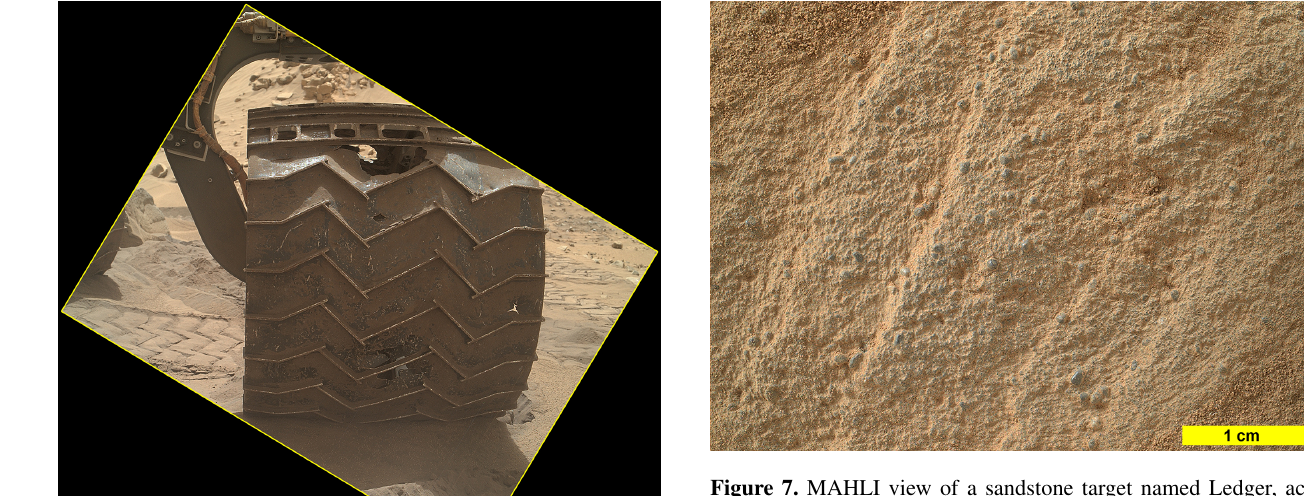
Figure 7. MAHLI view of a sandstone target named Ledger, ac- quired on sol 1092 (2 September 2015) after brushing, docu- menting the spot at which the APXS collected geochemical data. MAHLI acquires images from ∼ 7cm working distance (field of view ∼ 5 × 3.75cm) at most APXS science targets; this documen- tation is possible because the offset between the center of a MAHLI image and the center of an APXS integration spot is 0.5–5mm despite the instruments being positioned on opposite sides of the robotic arm turret (VanBommel et al., 2015). Image documenta- tion has proven to be crucial in assessing the amount of dust cover influencing the chemistry of APXS integration. On targets where dust has been largely cleared away by the Dust Removal Tool (DRT), MAHLI images record grains, veins, fractures and remnant dust that may contribute the measured APXS chemistry. This fig- ure shows Ledger shadowed by rover hardware (sunlight is oth- erwise from the upper left); this is onboard focus merge product